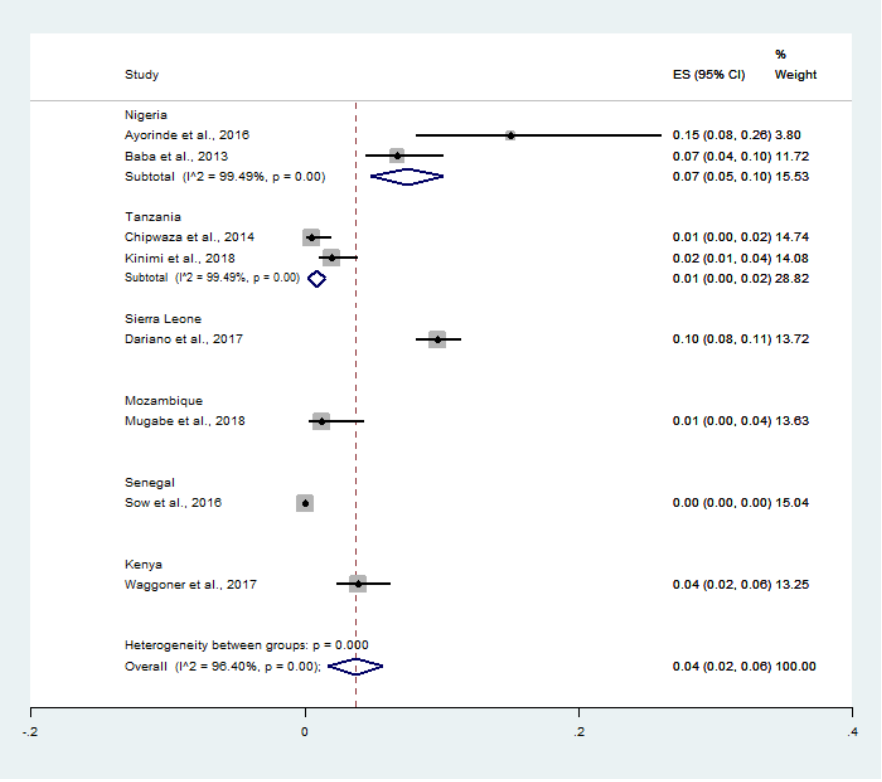
Figure 2. Prevalence of malaria and chikungunya co-infection among febrile patients by countries: % Weighted, the impact proportion of each study to the pooled effect; black dot symbol on the black horizontal line, the point estimate for each study; the black horizontal line, CI; the white diamond symbol, pooled prevalence; CI, confidence interval; ES , effect size ( prevalence ).